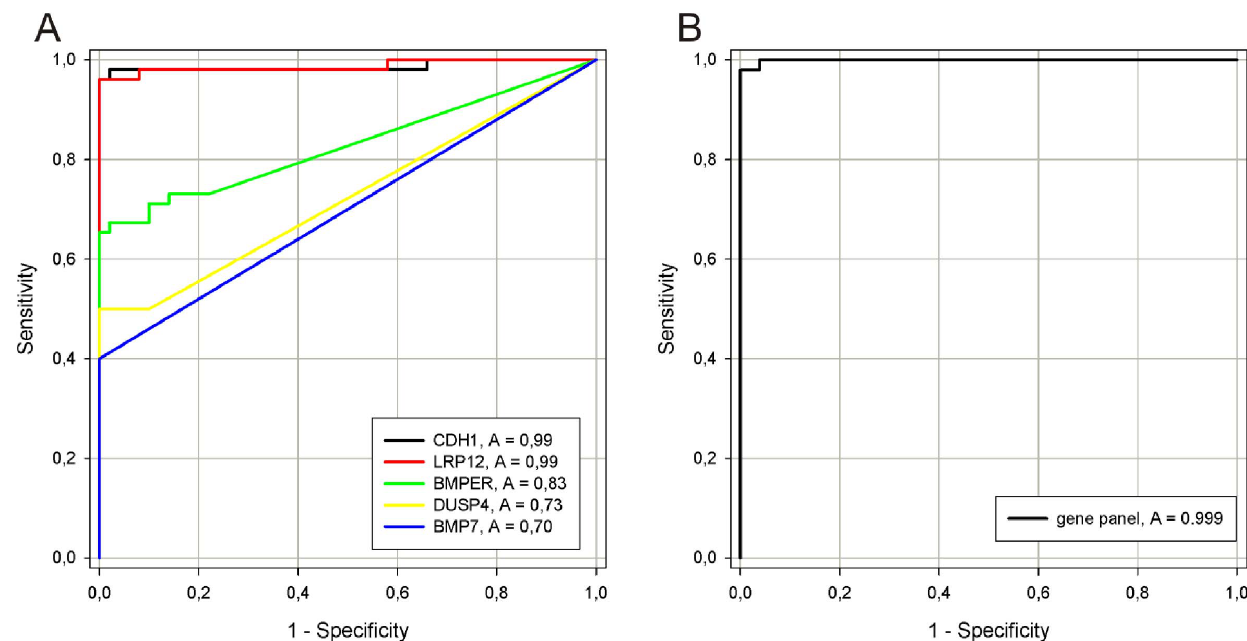
Figure 3. Receiver Operating Characteristics (ROC) curves for individual and combined markers in lymphoma patients versus healthy donors. The area under the ROC curve (AUC) represents how accurate the individual and combined biomarkers can discriminate between lymphoma and control samples. A) Lymphoma patients versus controls for individual genes. B) Lymphoma patients versus controls for the combined gene panel.